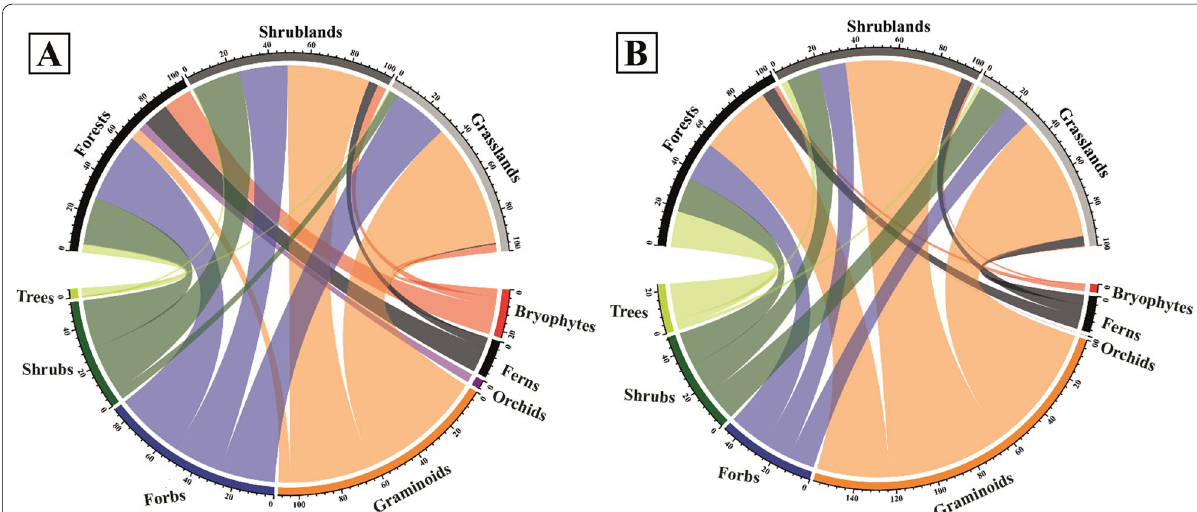
Fig. 5 Relationship between vegetation types and life forms for: A forage offer (based on ground cover, %) and B rabbit forage intakes (based on occurrence frequency in microhistological analyses, %). The coloured ribbons represent the links of each life form within the vegetation types